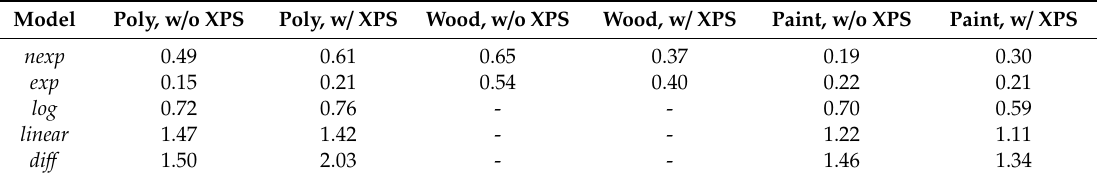
Figure 13. Different models for moisture movement away from injection site ( Q mrd ) in exposed OSB: measured OSB moisture content with model predictions ( a ) and residuals ( b ). Table 4. RMSE (% MC) for various Q mrd models with two parameters across all datasets.